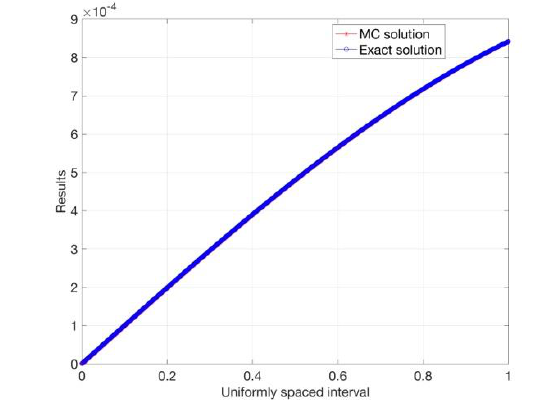
Figure 3. Comparison of the MC Prediction and the exact solution of equation (3)